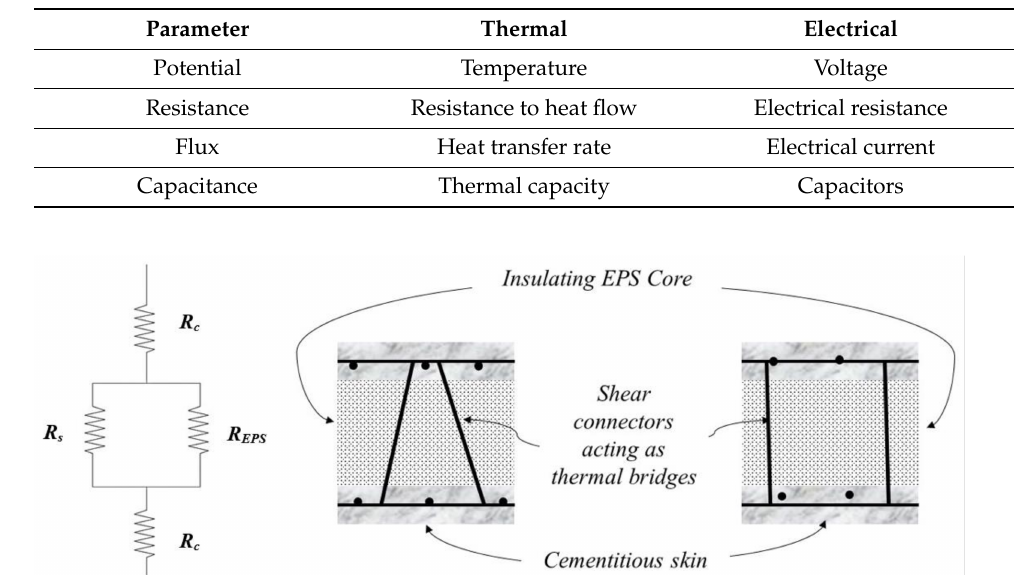
Table 3. Electrical Network Analogues for Heat Transfer Modeling.